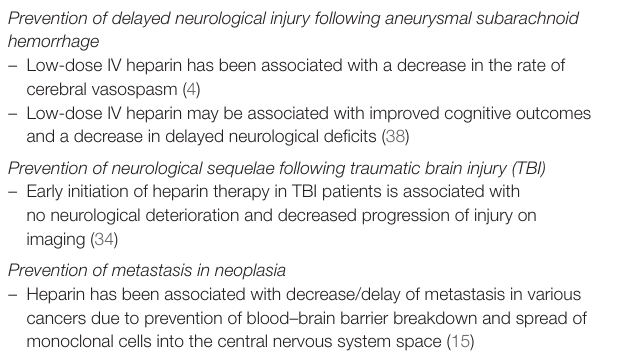
TABLe 2 | Human studies showing neuroprotection of heparin in various neurological injuries. Prevention of delayed neurological injury following aneurysmal subarachnoid